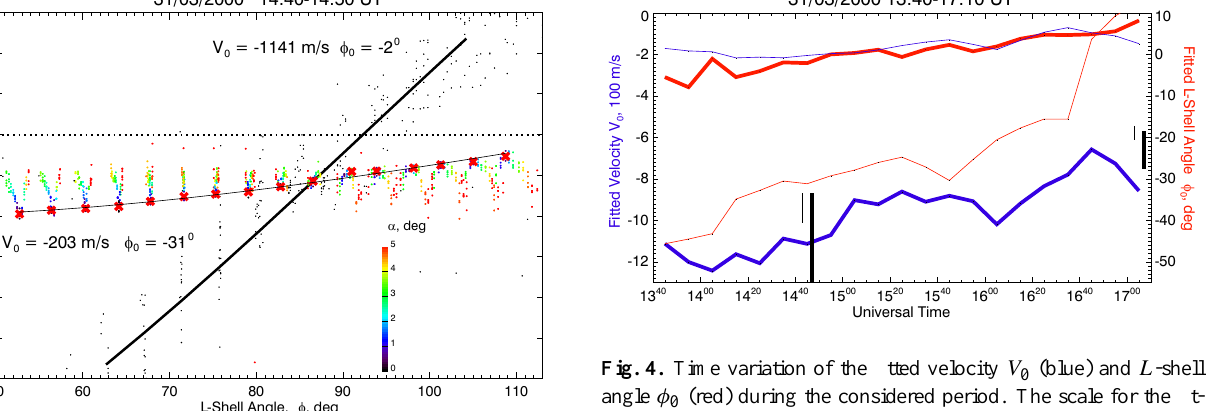
aspect angle is shown at the bottom right part of the diagram.